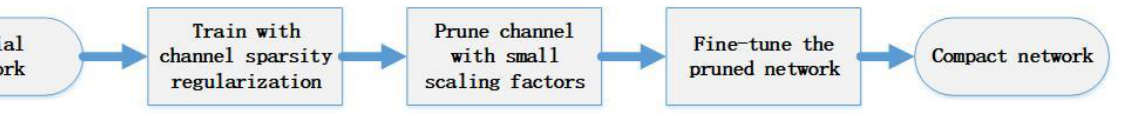
Figure 8. Flowchart of network slimming procedure.